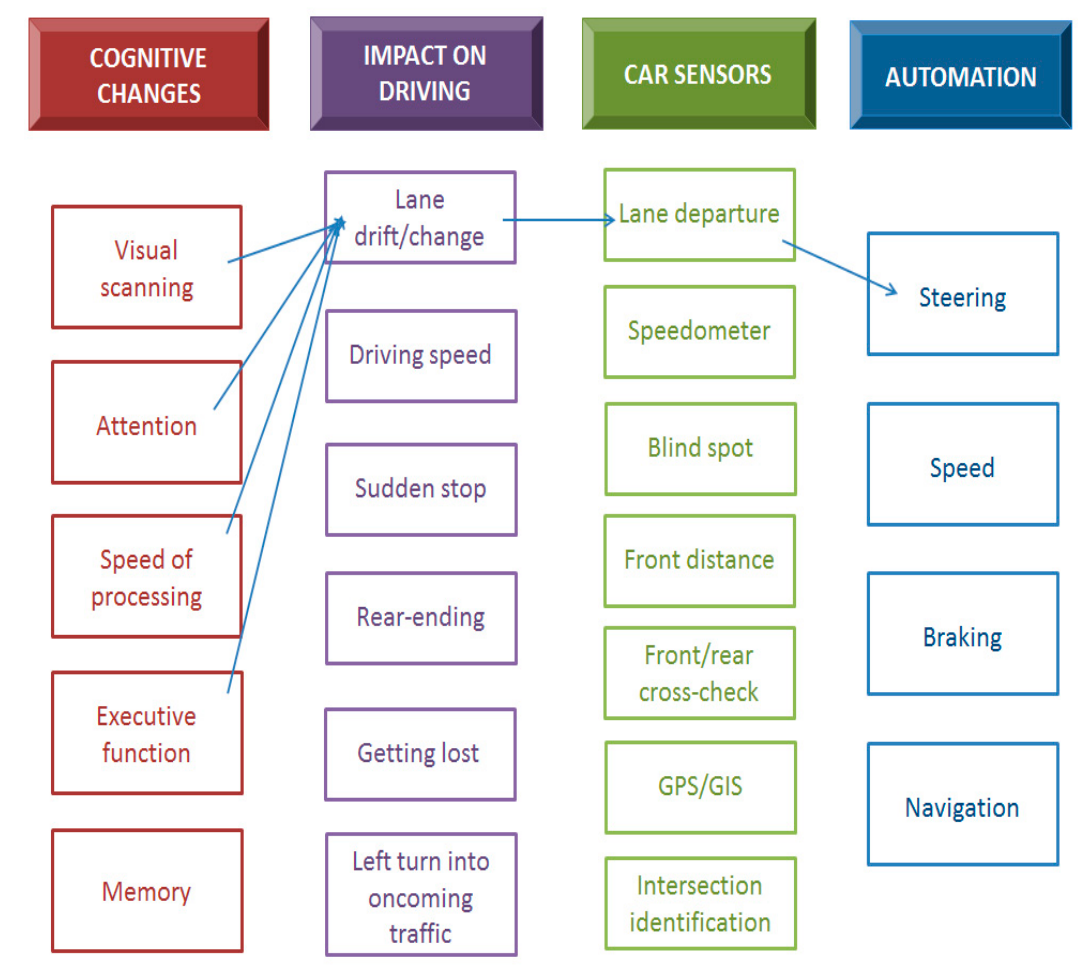
Figure 2. Example of cognitive changes impacting lane drift capacity.